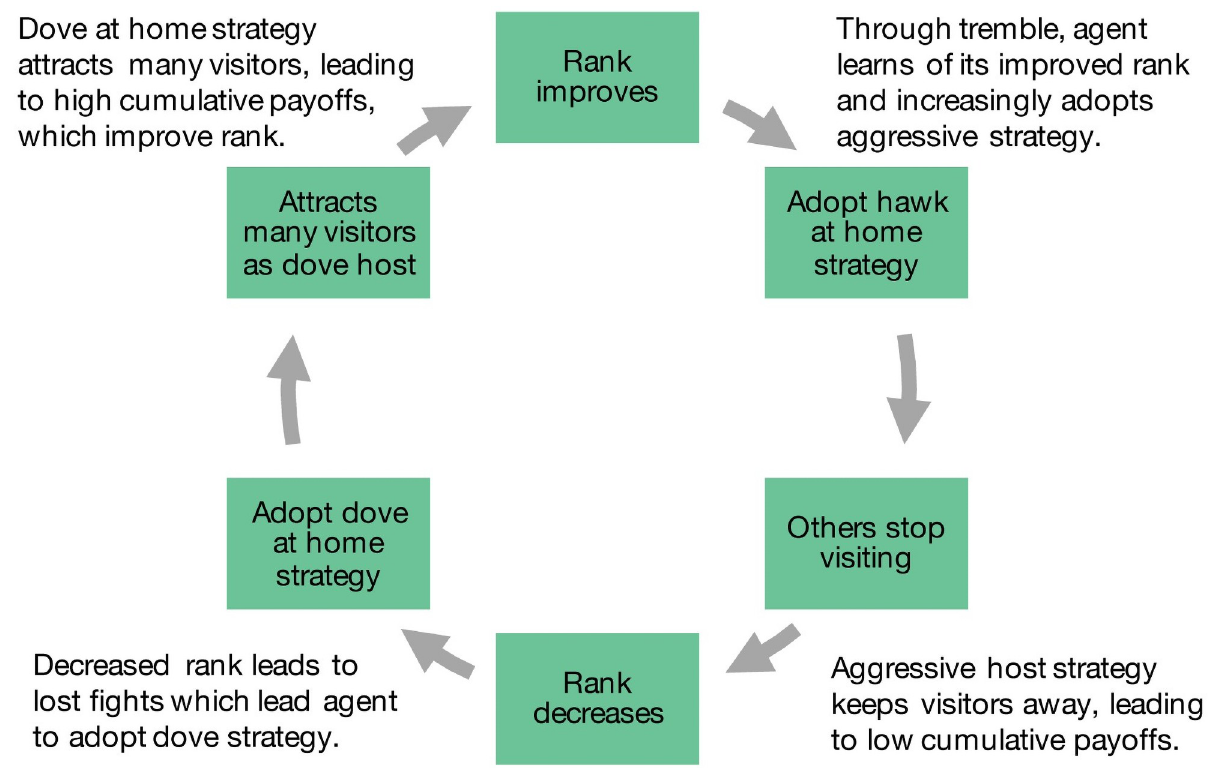
Fig 4. Cycles of interacting rank and strategy changes. Allowing individuals’ ranks to change based on cumulative payoffs (dynamic ranks) leads to coupled cycles of aggressive-cooperative strategy, shifting network position, and rising and falling rank.